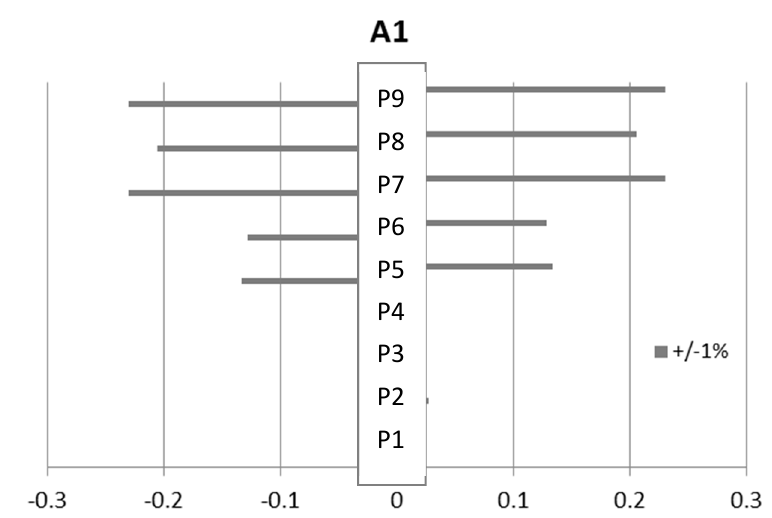
Figure 8. Sensitivity analysis of Alternative 1.